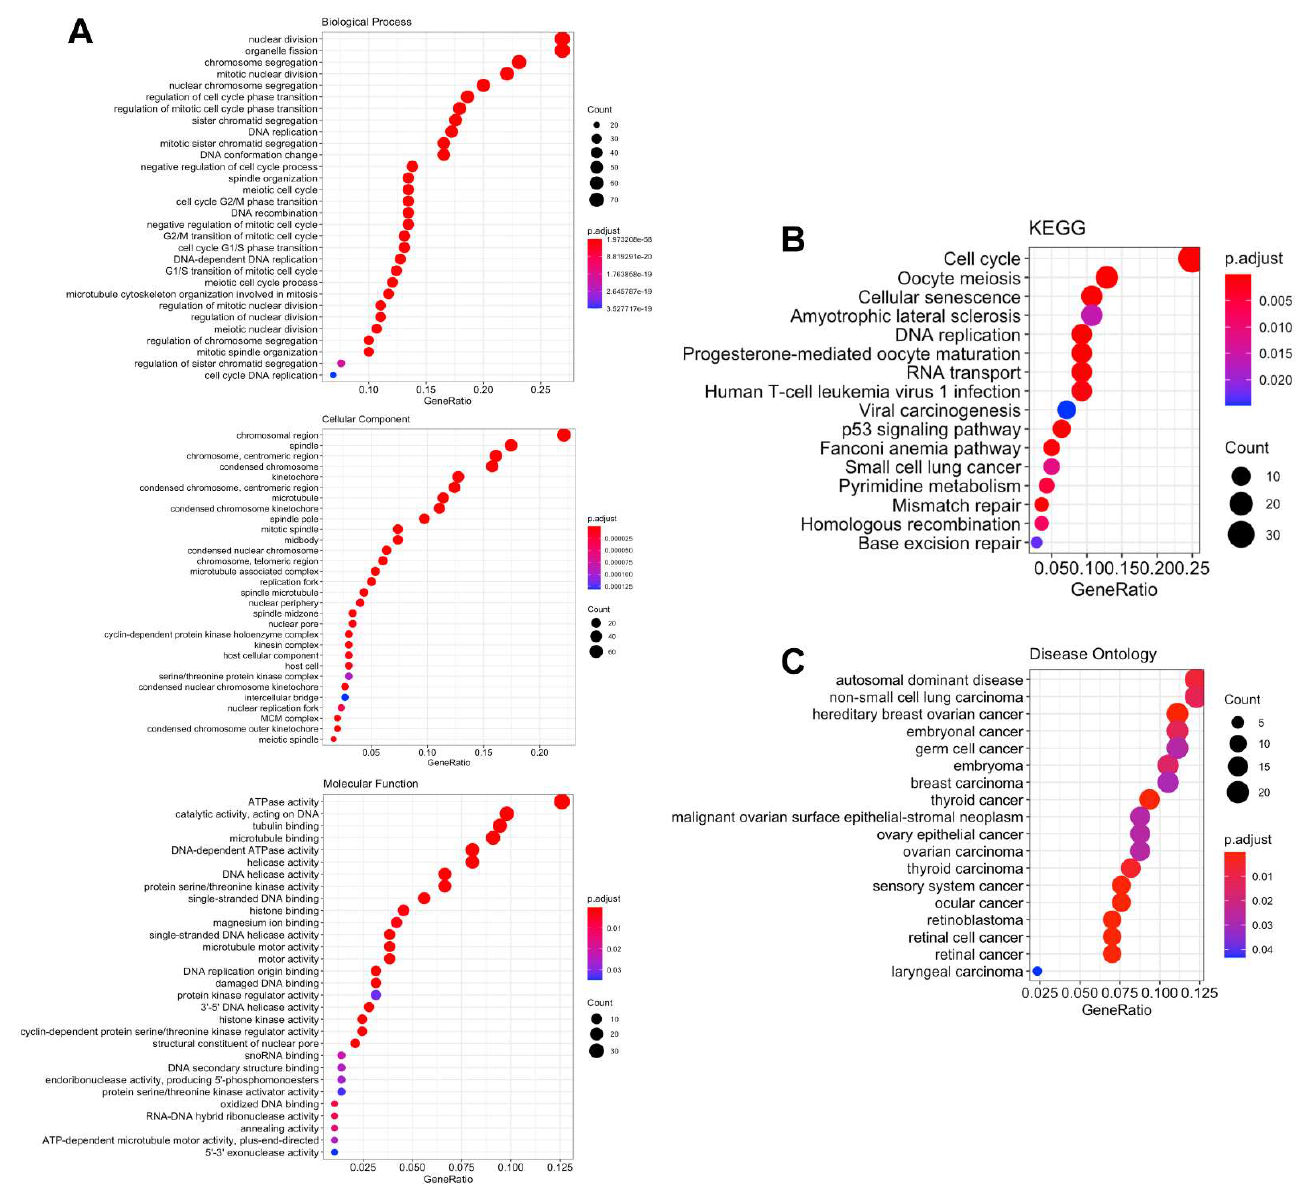
Figure 7. Functional and pathway enrichment analyses of GPSMs. (GO, KEGG). ( A ) Dot plot of Gene Ontology (GO) analysis. Shown are the most significant enriched categories for Biological process, Cellular component, and Molecular function. ( B ) Dot plot of Kyoto Encyclopedia of Genes and Genomes (KEGG) enriched analysis. ( C ) Dot plot of Disease Ontology analysis.